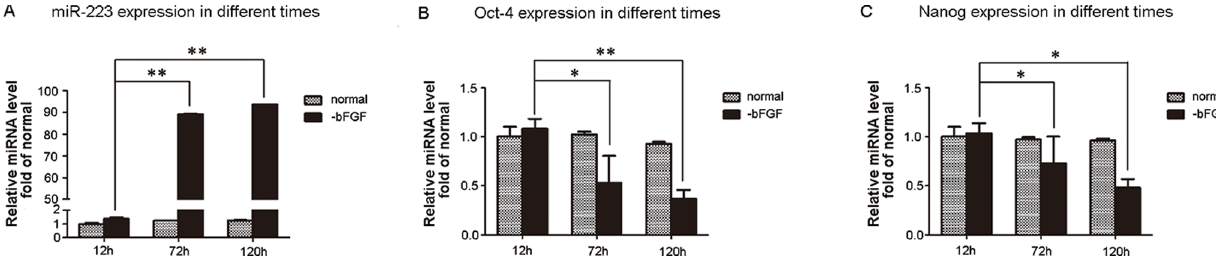
Figure 1. Levels of miR-223 detected in hESCs and spontaneously differentiated cells. A, Detection of miR-223 ( A ), Oct-4, ( B ), and Nanog ( C ) in hESCs and spontaneously differentiated cells 12, 72, and 120 h after withdrawal of bFGF (* p , 0.05; ** p , 0.01; n=6).